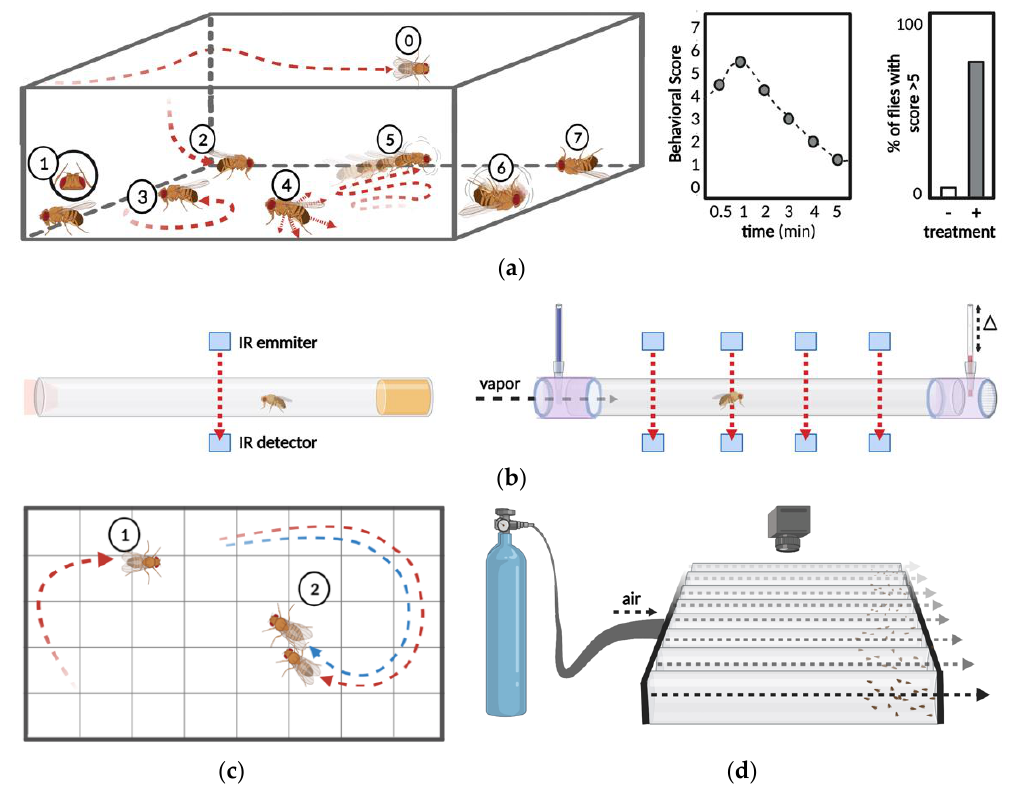
Figure 2. Assays for measuring the motor activating effects of psychostimulant drugs in Drosophila . ( a ) A representation of responses observed in the behavioral scoring assay at different concentrations of cocaine (left). Numbers correspond to the progression and severity of responses defined in the behavioral scale, which range from 0 to 7, as follows: (0) basal locomotion, grooming, and flight (1) decreased locomotion and increased grooming (2) simultaneous locomotion and grooming, proboscis extension, and loss of negative geotaxis (3) circling behavior and proboscis extension (4) leg twitching and erratic movements such as twirling and sideways or backwards locomotion (5) hyperkinesia and wing-buzzing (6) ataxia and seizures (7) akinesia and death. Graphs represent examples of how behavioral data are used to characterize the temporal dynamics of drug-induced responses (middle) as well as drug effect scores (right) which are represented here in an example comparing the percent of untreated flies (white bar) and drug-treated flies (grey bar) with behavioral score higher than 5, during a 1 min observation period. ( b ) Drosophila Activity Monitor (DAM) system cuvettes for measuring infrared (IR) beam breaks as a readout of locomotor activity. For chronic exposure experiments, drugs can be added to food (Left). In the newer Drosophila Activity Monitor 5M (DAM5M) each cuvette is intersected by 4 infrared beams, providing information on locomotion and position (right). Variations of the DAM allow acute administration of vaporized cocaine while measuring consumption and preference for individual Drosophila . In this setup, flies have access to two different feeding solutions in capillary tubes positioned at each end of the cuvette (right). Consumption is measured based on the displacement ( ∆ ) of the solution, represented by the black dashed line. ( c ) A depiction of two different video-recorded locomotor assays with software driven automated analysis (1) the open field assay (2) courtship tracking assay ( d ) A schematic of the Repetitive Startle-induced Hyperactivity (ReSH) assay where locomotor response to mechanical stress is measured across eight tubes after flies are forced to one side with repetitive puffs of air. Created with